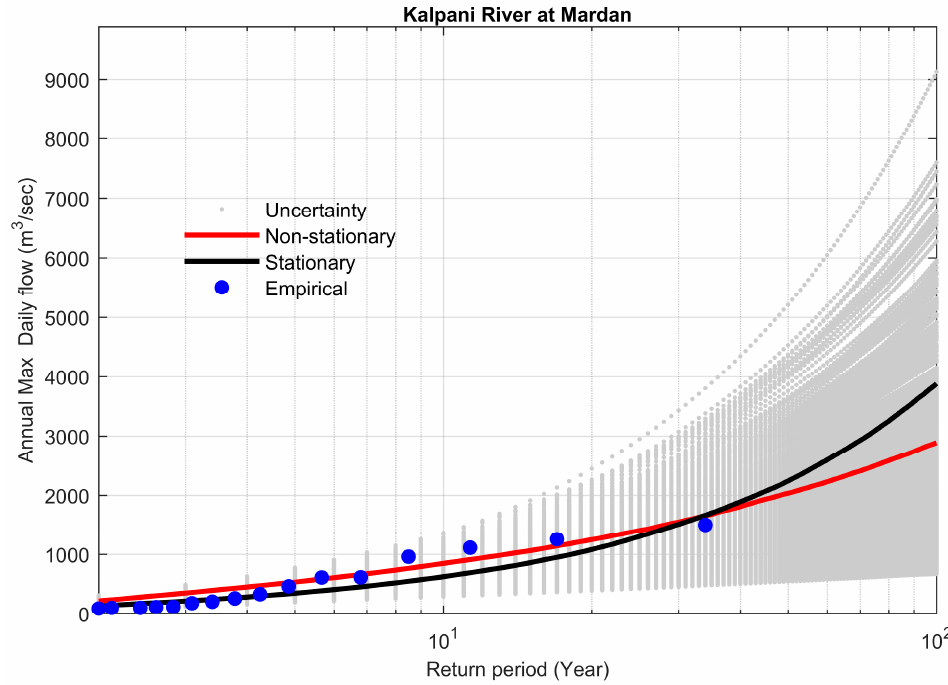
Figure 5. Comparison between non-stationary and stationary FFCs at site 18, along with non- stationary uncertainty bounds for the year 2016.